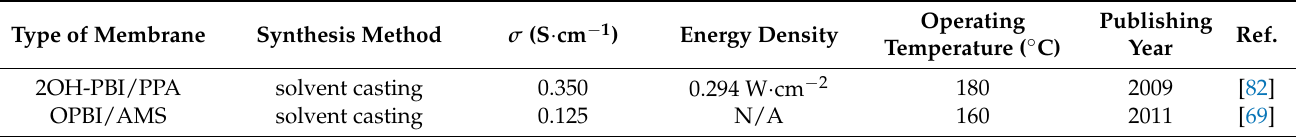
Table 2. The membrane properties of some representative studies on PBI PEMs in hydrogen-air PEMFCs (Acid components have been omitted in the column of “type of membrane” for phosphoric acid doped cases.). Type of